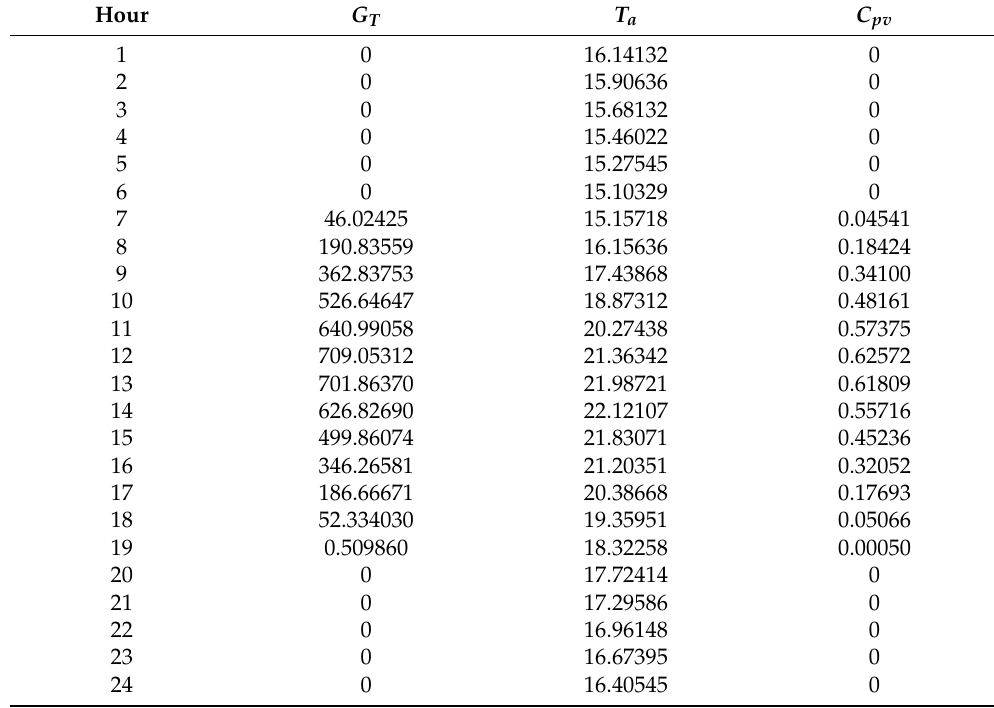
Table 1. Parametric information on PV generation: solar radiation (W/m 2 ), environmental tempera- ture (°C), and PV power generation in